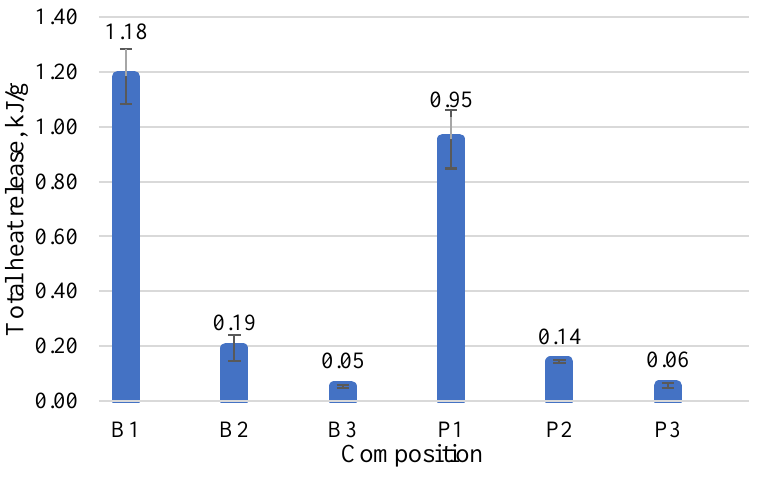
Figure 7. The maximum average heat-rate emission (MAHRE) of BACs. Total heat release (THR) rate results between test time 0 and 300 s indicate the role of material density on heat release rate for 1g of material (Figure 8). Rapid burning of B1 and P1 BAC and the low density of material provides a high THR rate—1.18 kJ/g for B1 and 0.95 kJ/g for P1, respectively. This corresponds to the appearance of BAC after the test when B1 and P1 samples were completely disintegrated. A significant THR decrease was achieved by B2, B3, P2, and P3. Limited flaming and burning of BACs show a THR decrease to 0.19 kJ/g for B2 and 0.14 kJ/g for P2. B3 and P3 compositions reduced THR to 0.05 kJ/g and 0.06 kJ/g.